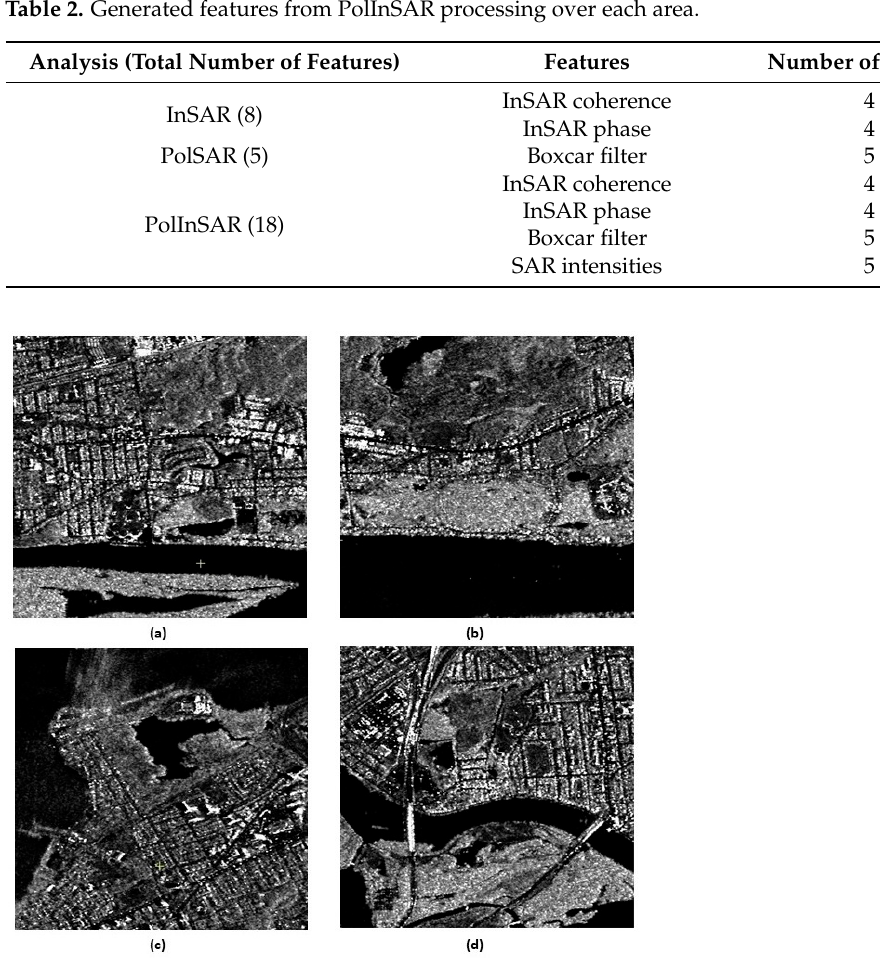
Figure 6. PolSAR Boxcar filtered images derived from the co-flood TerraSAR-X image over ( a ) Area1, ( b ) Area2, ( c ) Area3, and ( d ) Area4. ( b ) Area2, ( c ) Area3, and ( d )